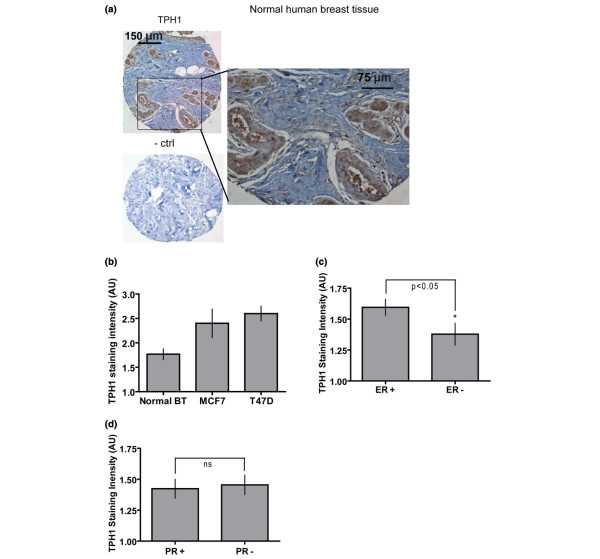
Changes in TPH1 signal in human breast tumors. (A) Representative image of normal human breast tissue (BT) from the tissue microarray stained for TPH1 (brown) and counterstained with hematoxylin. A corresponding no primary antibody control section is depicted on the bottom left. Magnified image shows details of epithelial staining and occasional positive cells in stroma. (B-D) Results depicting quantification of TPH1 immunostaining from blindly scored tissue microarray sections. The section scores for TPH1 were sorted as per human cancer cell line core (B), estrogen receptor (ER) status (C) and progesterone receptor (PR) status (D). TPH1 staining was reduced in ER negative tumors, but unaffected by PR status. Error bars represent ± SEM. *P < 0.05 in comparison with normal BT for (A).